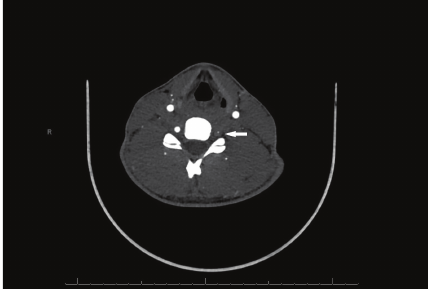
Figure 2: CT Angiogram showing the filling defect in left vertebral artery (marked by white solid arrow).